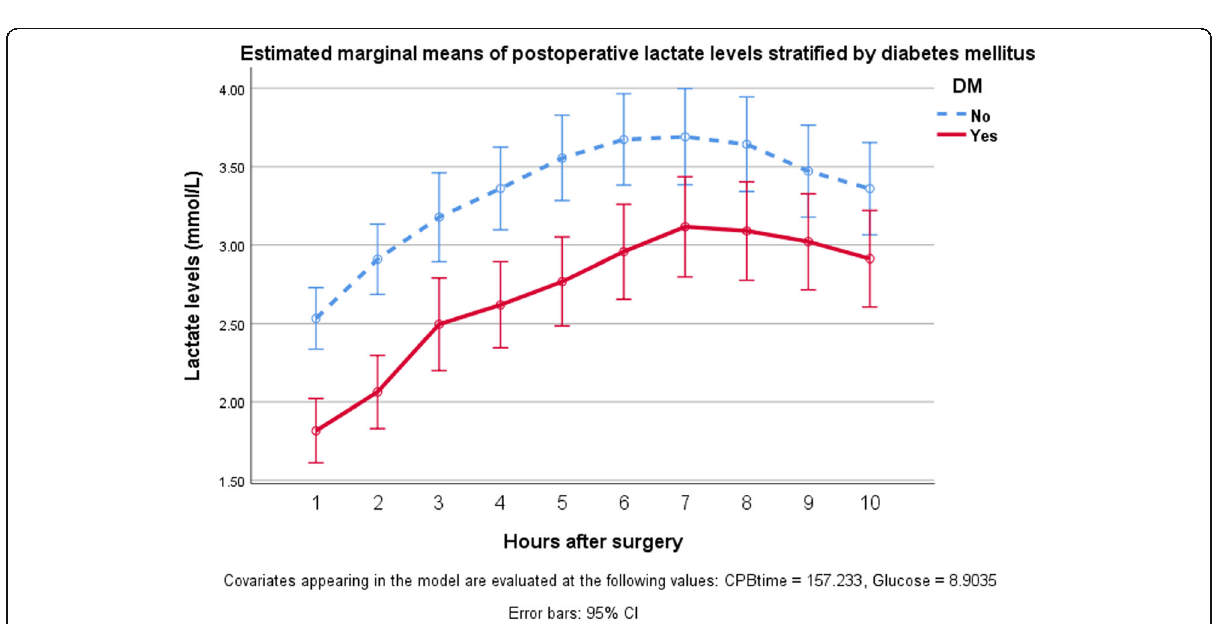
Fig. 3 The effect of diabetes mellitus on postoperative lactate levels while controlling for the effect of covariates (CPB time and glucose level). DM is associated with a significant attenuation of the postoperative lactate levels ( P < 0.001). CPB indicates cardiopulmonary bypass. 95% CI indicates 95% confidence interval. DM indicates diabetes mellitus. Estimated marginal means for lactate levels with the 95% CI for each time point in both groups are detailed in the Supplement (Table